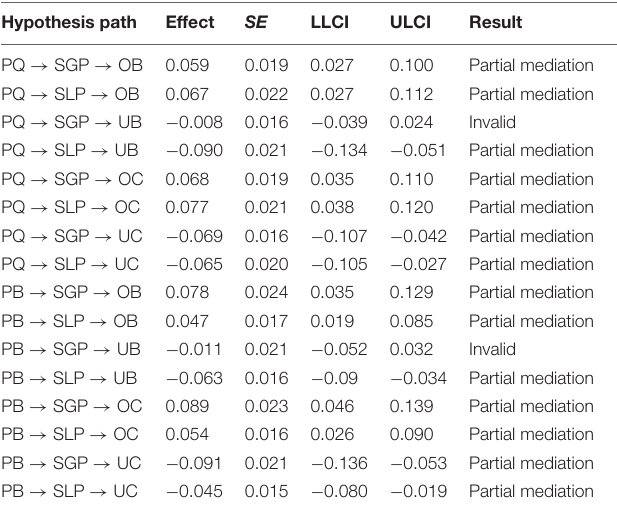
TABLE 4 | Mediate effect test of